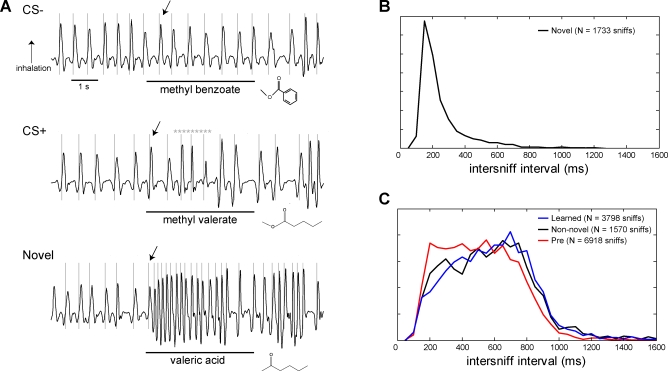
Exploratory Sniffing Evoked by Novel Odorants(A) Respiratory behavior in a head-fixed rat performing a lick/no-lick discrimination of two familiar odorants (top two traces) and during presentation of a novel odorant (bottom trace). Inhalation is up. Vertical lines mark the start of each inhalation. Arrows mark the first inhalation in the presence of odorant. Asterisks in middle trace show time of licking to receive water reward. There is no appreciable change in respiration in response to the learned odorants, but the novel odorant elicits high-frequency, exploratory sniffing.(B) Distribution of ISIs for all inhalations during novel odorant presentations.(C) Distribution of ISIs for all presentations of learned odorants (blue), all third and subsequent presentations of novel odorants (black), and all pre-odor epochs (red). Plots are based on histogram distributions with 50-ms time bins.